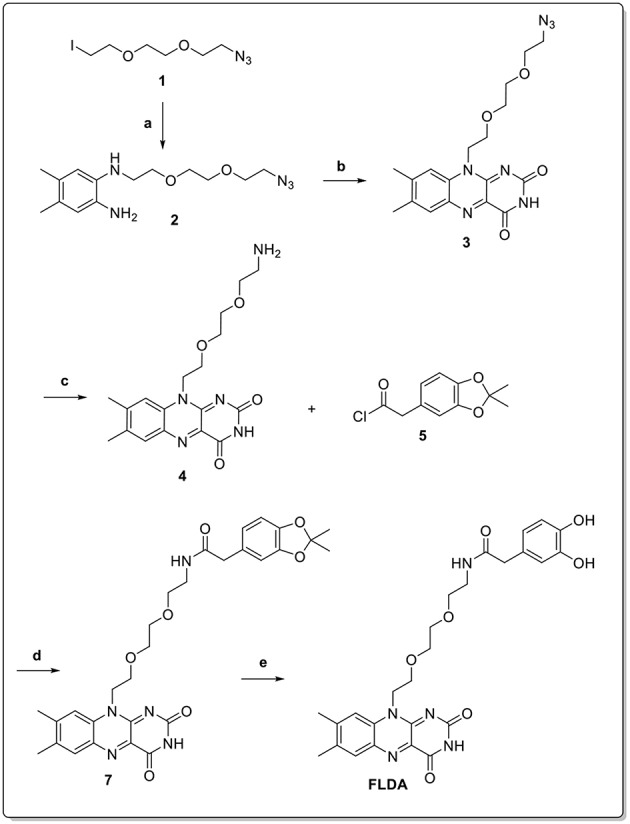
Reaction conditions: (a) 4,5-dimethylbenzene-1,2-diamine, K2CO3, DMF, 50 °C, 12 h (70%); (b) alloxan monohydrate, B2O3, AcOH, RT, dark, 48 h (69%); (c) Pd/C, H2, AcOH, RT, dark, 18 h (84%); (d) TEA, DMF, RT, dark, 18 h (62%); (e) TFA/DCM, RT, dark, 2 h (99%).